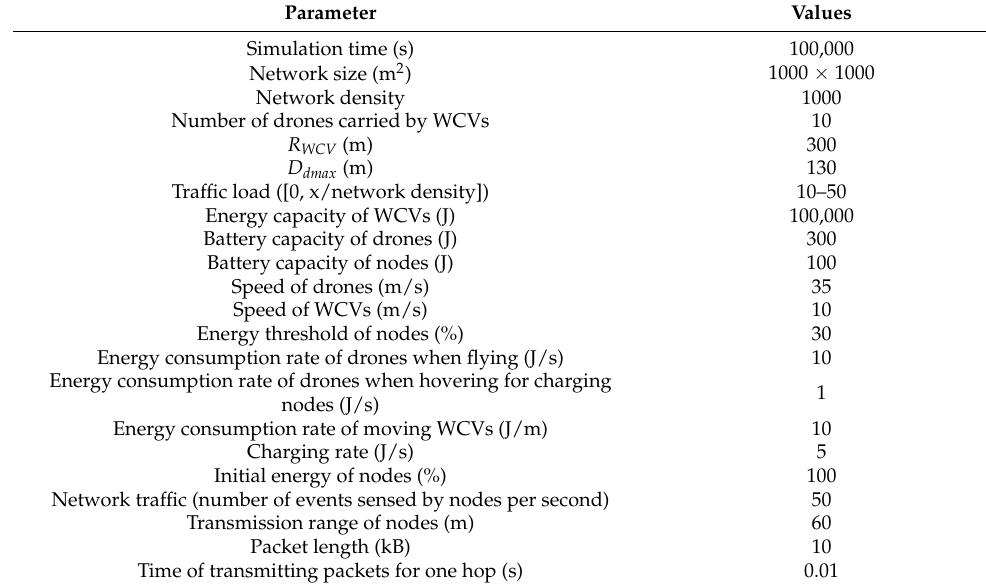
Table 4. Simulation parameters of the collaborative charging